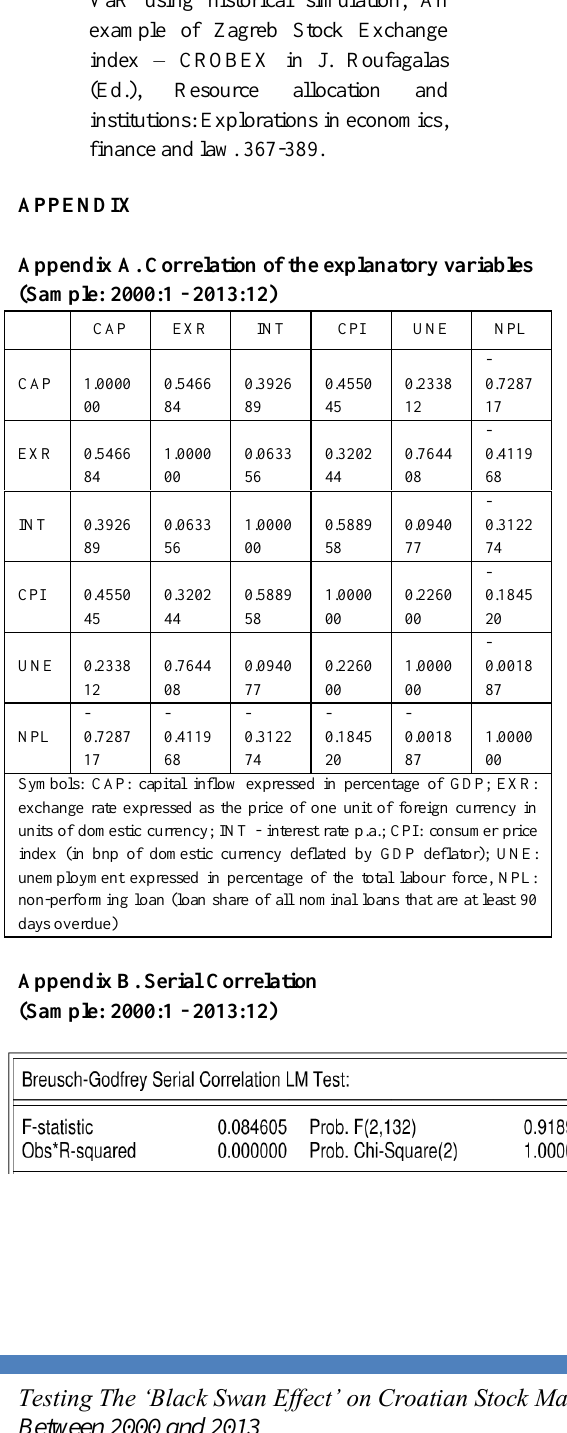
Testing The ‘Black Swan Effect’ on Croatian Stock Market Between 2000 and